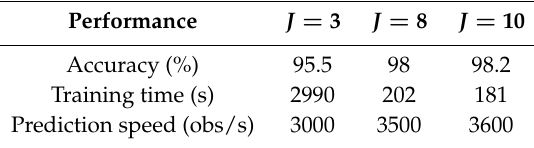
Table 4. Summary of the obtained